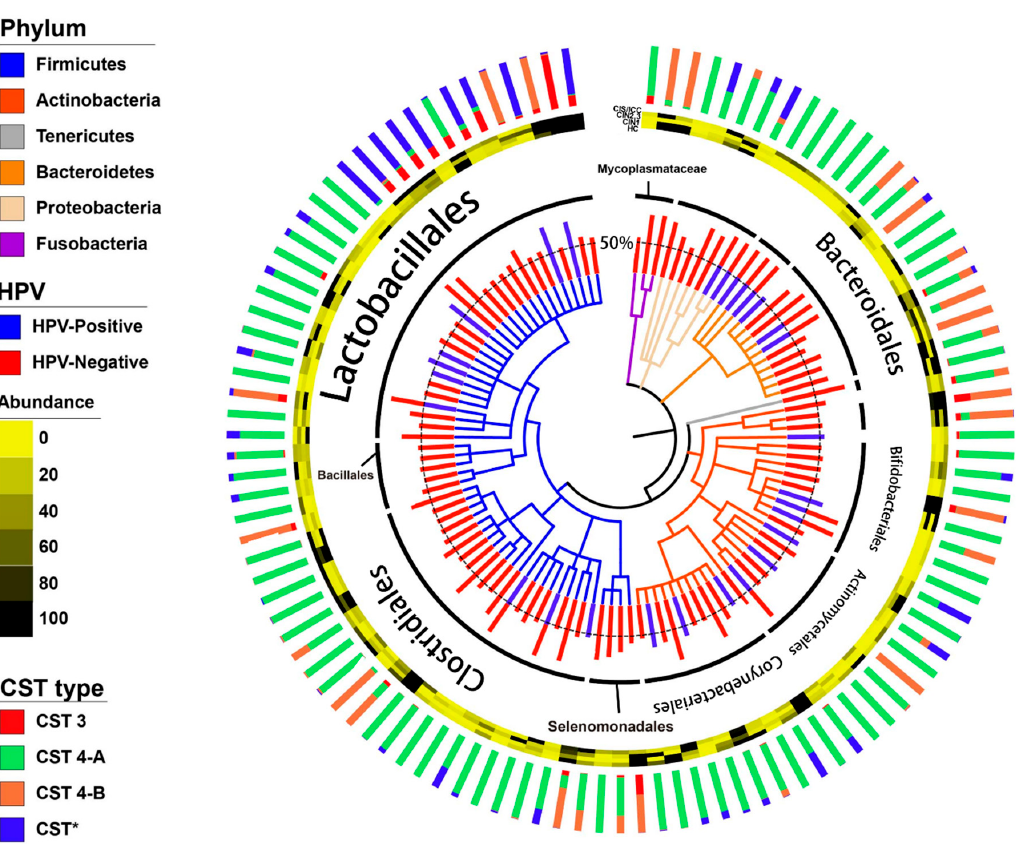
Figure 1. Phylogenetic trees of the vaginal microbiome network by metadata. From outside to inside, the stacked bar chart represents normalized relative abundances of community state type (CST)-related bacterial species; the heatmap represents each clinical stage; the bar charts were enriched in each HPV status, and the trees were grouped according to the phylum level.